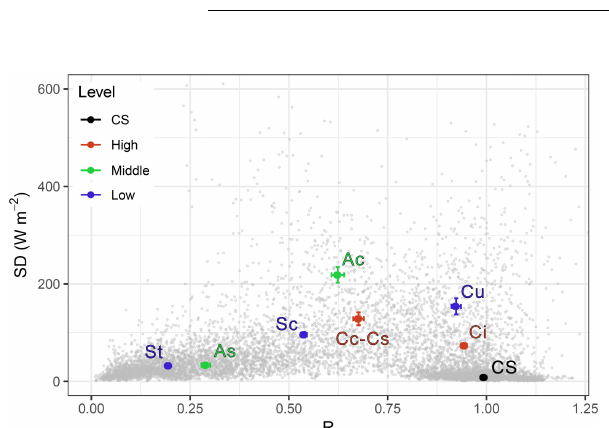
Figure 4. Cloud classification based on the improved broadband so- lar radiation following Duchon and O’Malley (1999) and Harrison et al. (2008) coupled with lidar data of cloud base height. From left to right: stratus (St), altostratus (As), stratocumulus (Sc), altocu- mulus (Ac), cirrocumulus and cirrostratus (Cc–Cs), cumulus (Cu), cirrus (Ci), and finally clear-sky (CS) conditions. The SD– R plot reports in grey the single data of the whole dataset, while centroids and the 99% confidence interval of each cloud type are plotted in a colour scale related to the cloud base